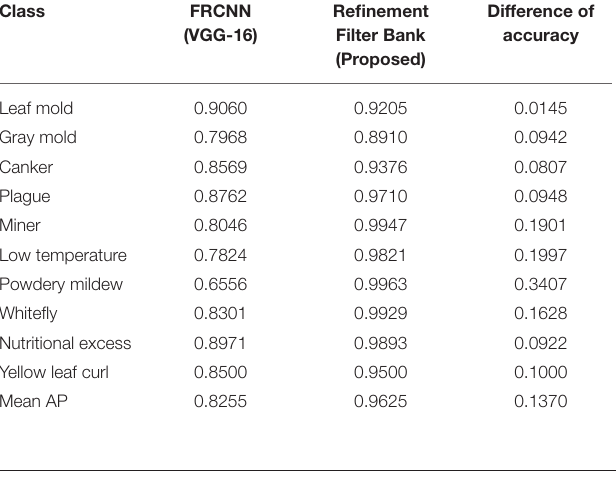
TABLE 3 | Comparative results of our proposed approach with the previous system ( Fuentes et al., 2017b). Class